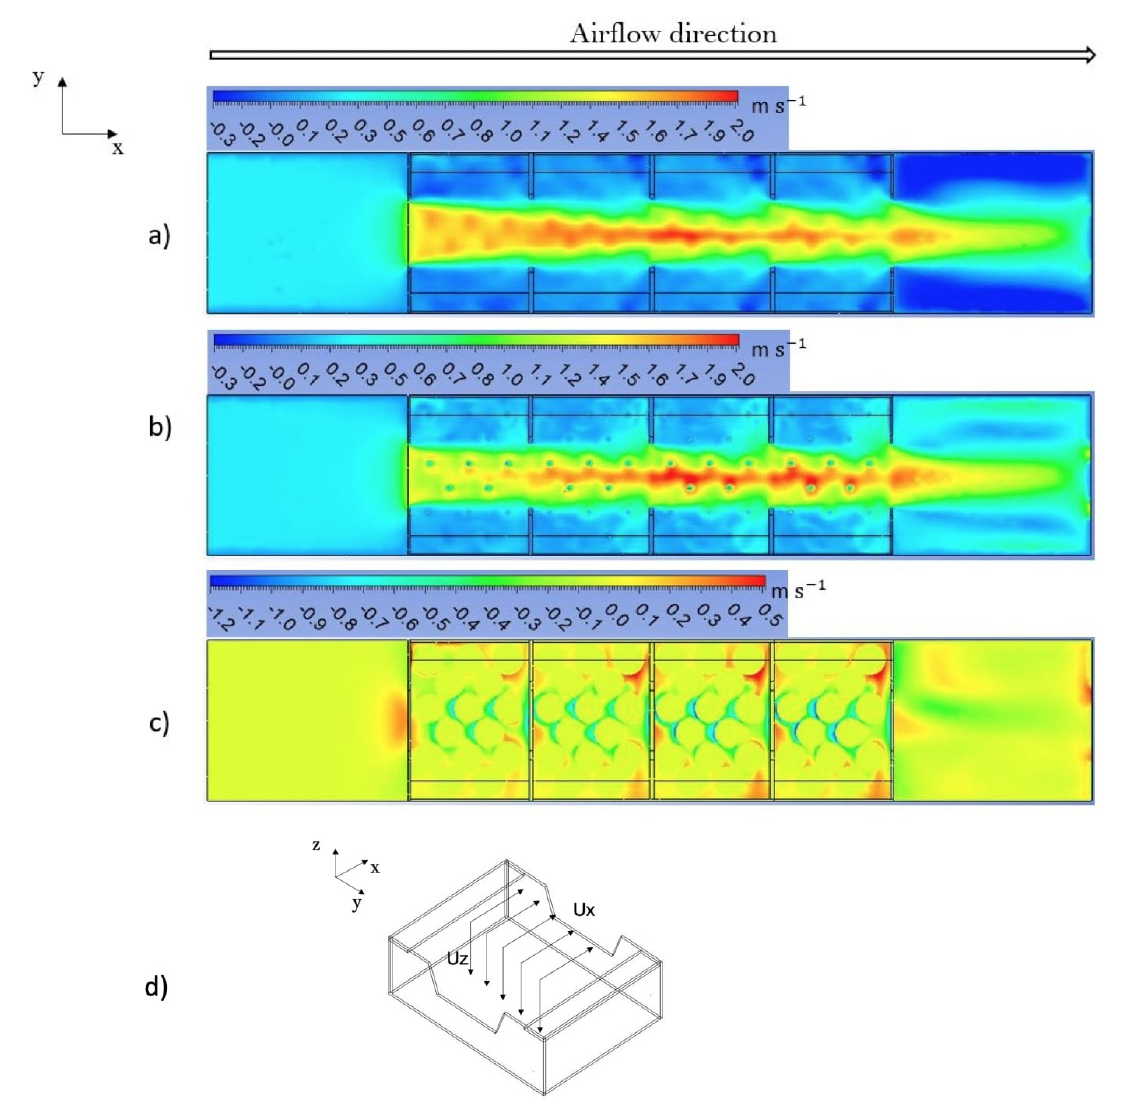
Figure 9. Velocity field of the airflow in the xy plane (crate A design): ( a ) u x at z = 85 mm; ( b ) u x at z = 75 mm; ( c ) u z at z = 37.5 mm; ( d ) illustration of the flow directions of u x and u z.